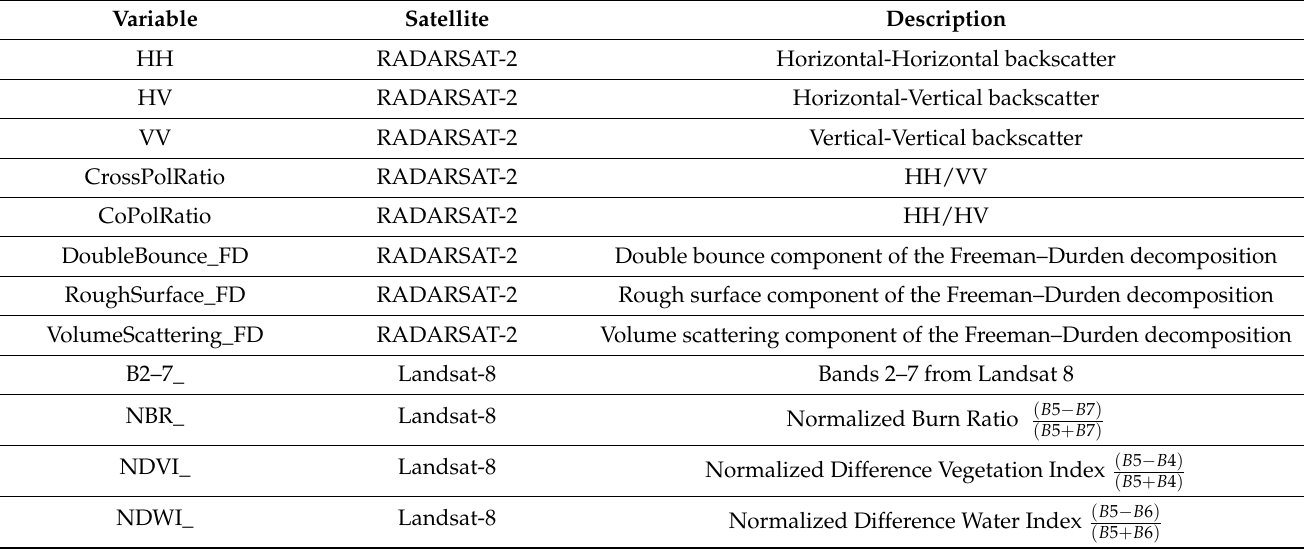
Table 2. List of EO inputs for Yellow Rail